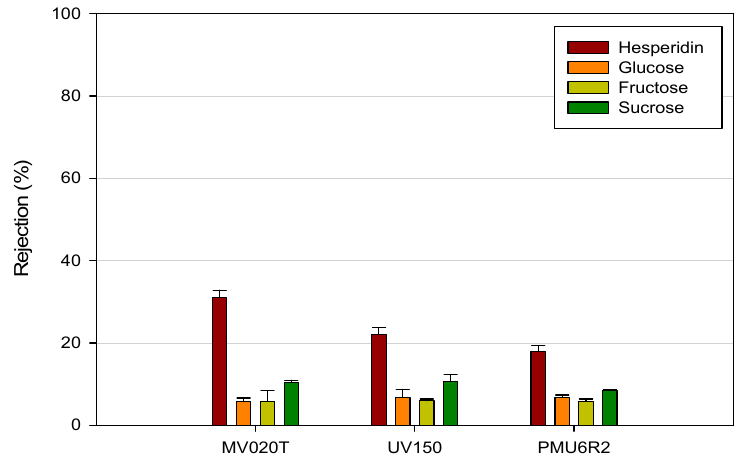
Figure 7. Rejections of sugars and hesperidin for selected membranes under batch concentration configuration. Operating conditions: TMP, 1 bar; temperature, 26.0 ± 1.0 °C; and feed flowrate, 185 L/h.